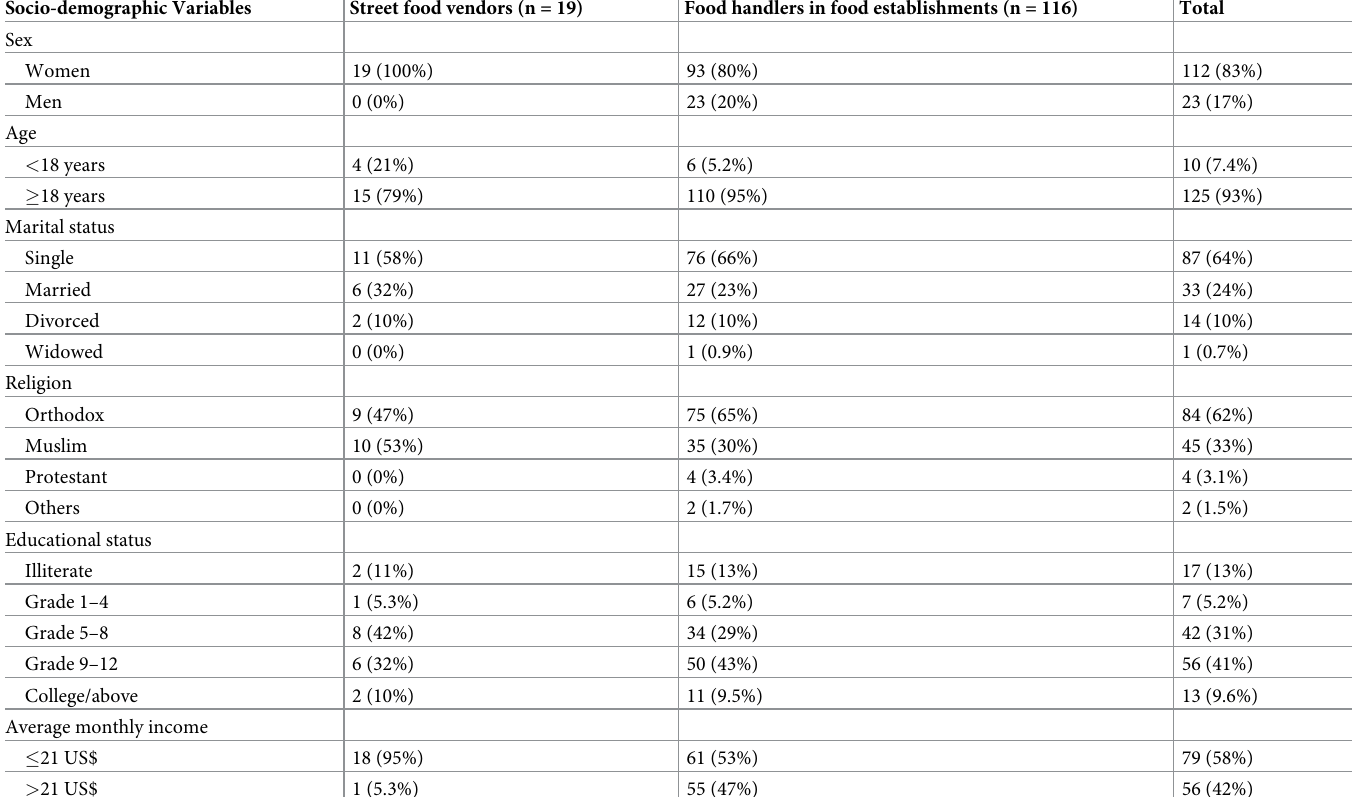
Table 1. Socio-demographic characteristics of street food vendors and food handlers in food establishments from December 2013 to June 2014, Dessie town, Ethiopia. Socio-demographic